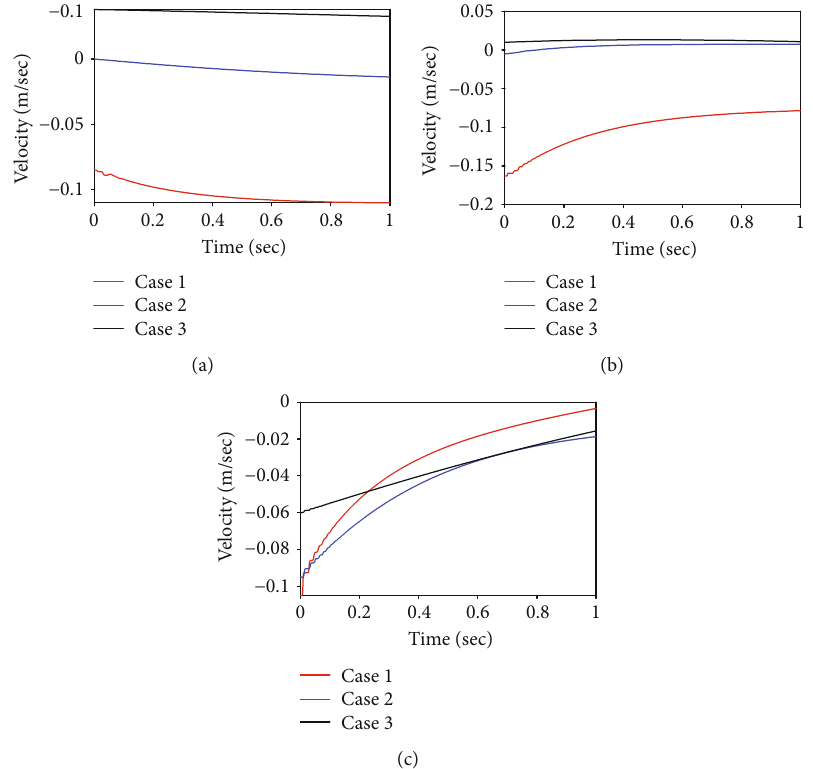
Figure 21: Linear velocity of the point O